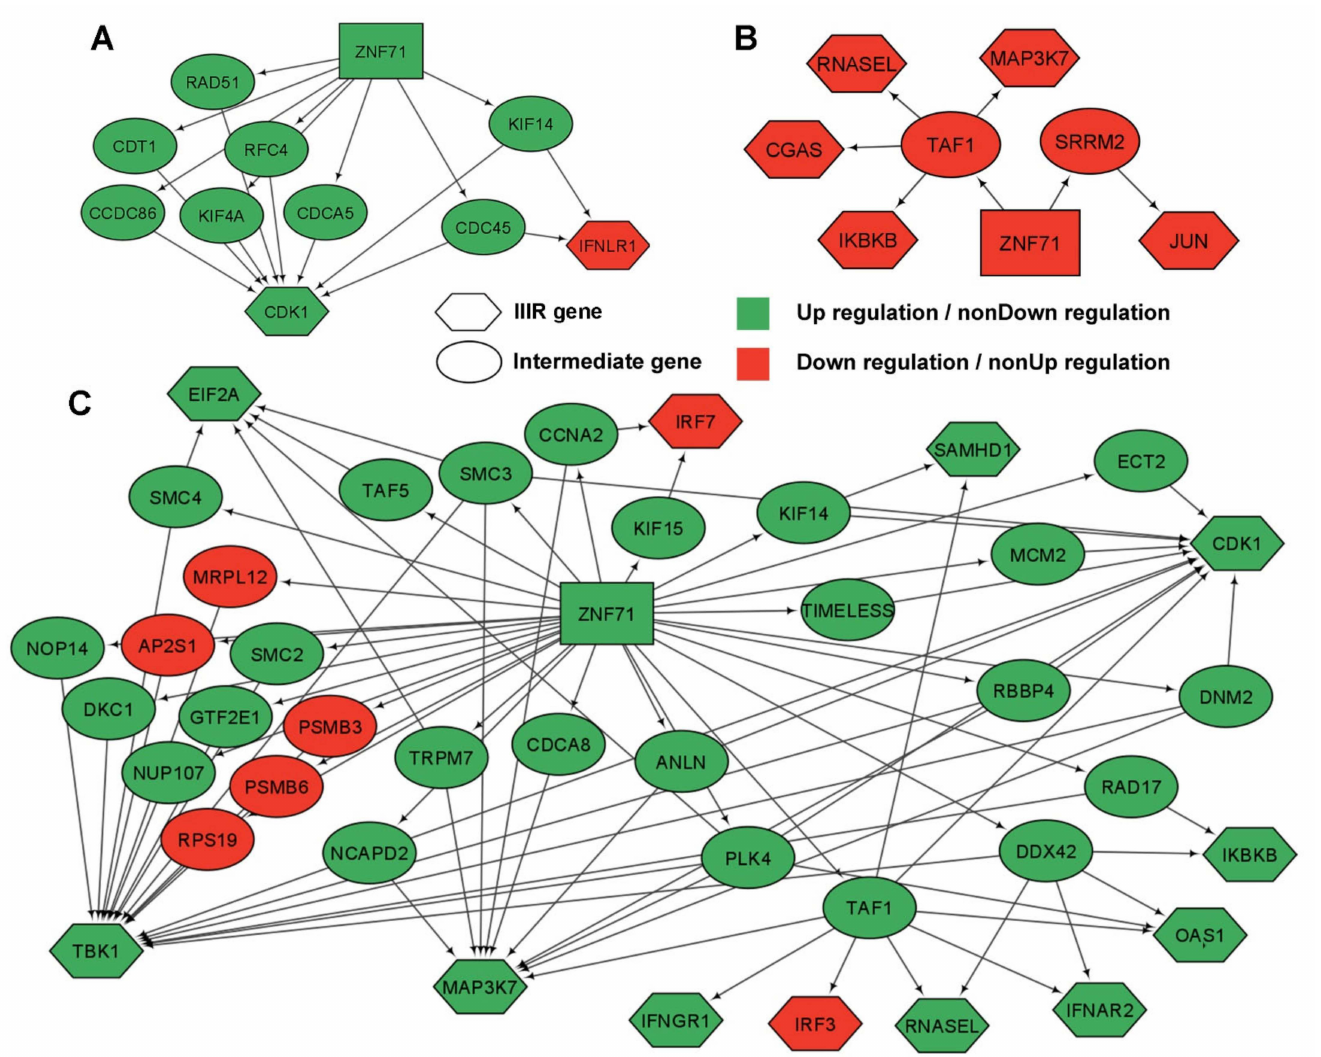
Figure 6. Indirect gene co-expression networks of ZNF71 and intracellular innate immune response (IIIR) genes in lung adenocarcinoma (LUAD) patient samples using RNA sequencing data. ( A ) Gene associations of ZNF71 with IIIR genes through intermediate genes in LUAD tumors when ZNF71 is upregulated. ( B ) Gene associations of ZNF71 with IIIR genes through intermediate genes in NATs when ZNF71 is downregulated. ( C ) Gene associations of ZNF71 with IIIR genes through intermediate genes in NATs when ZNF71 is upregulated. ZNF71 is in a rectangle. Third, although ZNF71 was not available in LUAD proteomics data from Xu et al. [33], ZNF71 mRNA expression had indirect associations with the protein expression of some IIIR genes through intermediate genes. The indirect gene association networks of